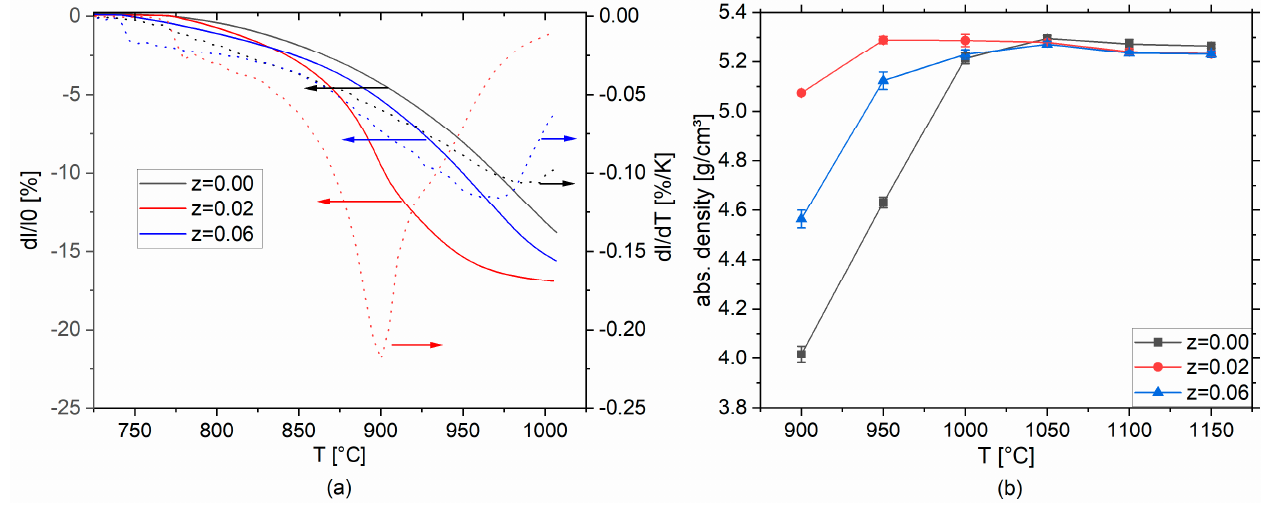
Figure 1. ( a ) Relative shrinkage and shrinkage rate vs. temperature and ( b ) absolute density vs. sintering temperature for 0 ≤ z ≤ 0.06.